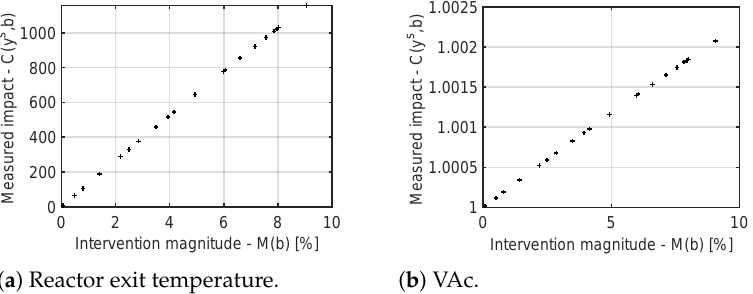
Figure 8. Attestation result on two observable variables with intervention on the HAC feed product.